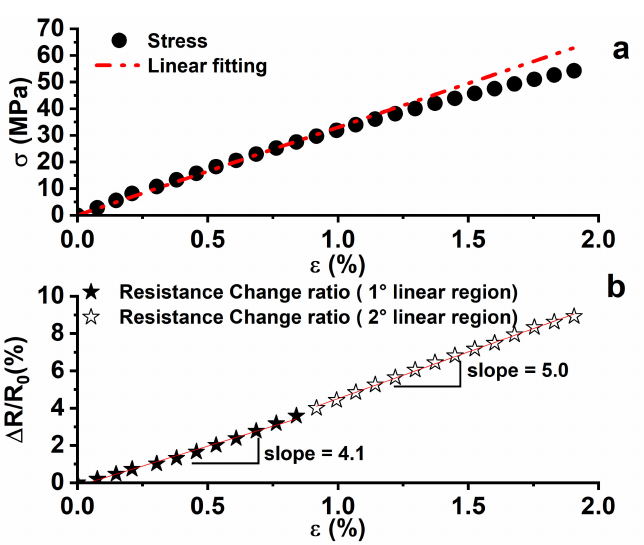
Figure 6. ( a ) Mechanical response and ( b ) resistance change ratio vs. the axial strain for the epoxy system filled with 0.5% by weight of the carbon